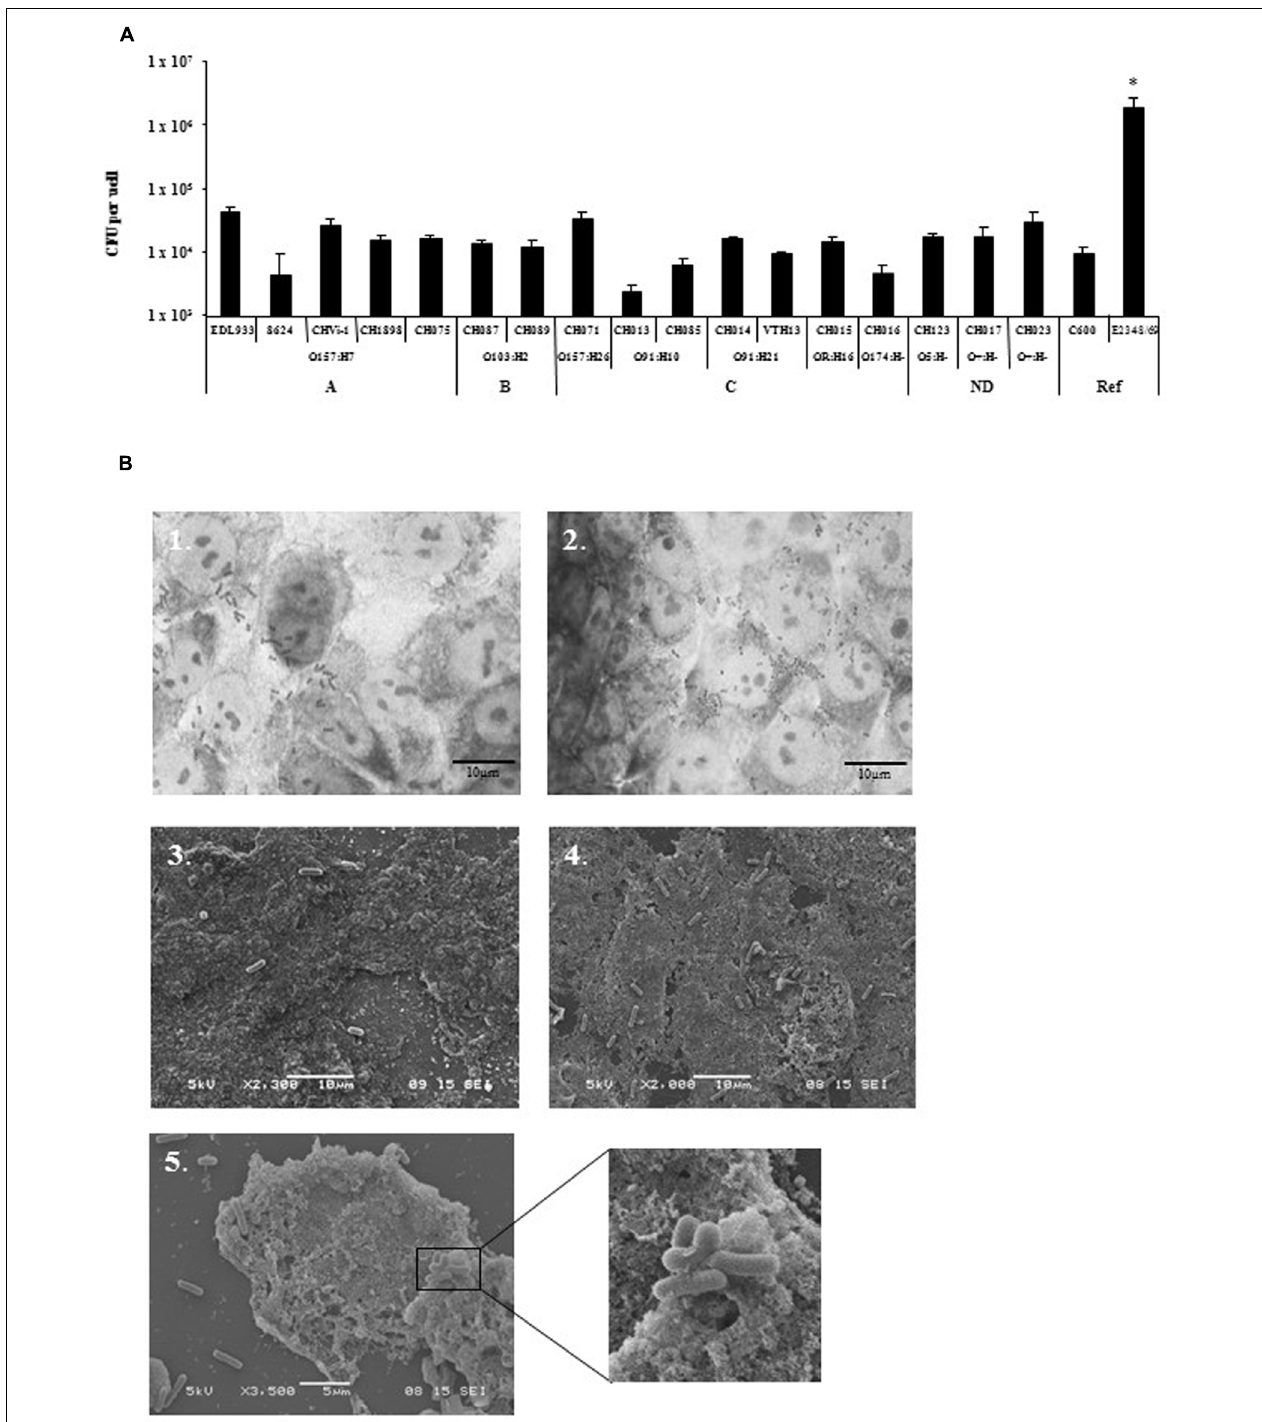
determined; Ref, reference strains. *The level of adhesion of EPEC E2348/69 strain was significantly different from all other strains tested ( p < 0.01). (B) Adhesion pattern of EHEC O157:H7 (EDL933) strain (1, 3) and EPEC (E2348/69) strain (2, 4, and 5) stained with Giemsa (1, 2), or after scanning electron microscopy (SEM) analysis (3, 4, and 5). Scale bar = 10 μ m for Giemsa and SEM, Magnification × 2,300 (3), × 2,000 (4), × 3,500 (5) and x10,000 (enlarged